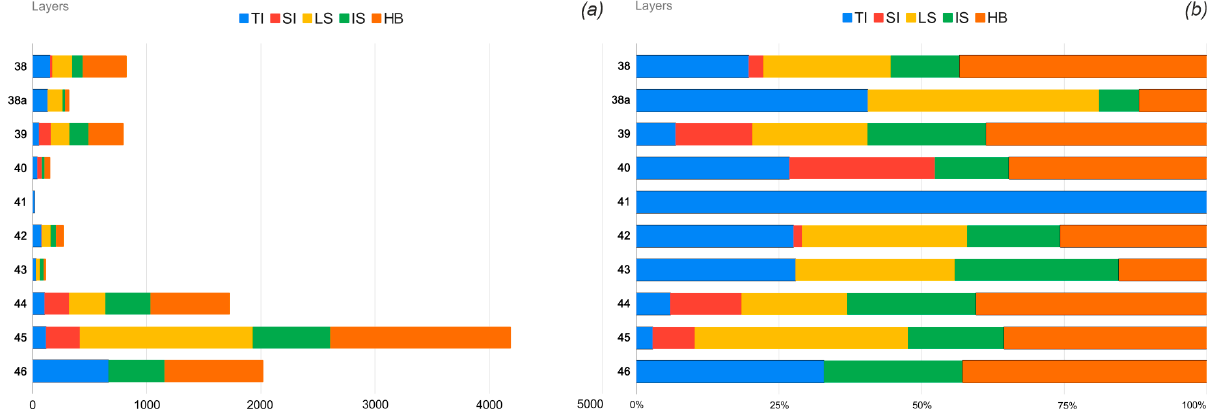
Figure 6. Ladder diagrams showing contributions to structural complexity (bits per unit cell) ( a ) and normalized contributions (in %) ( b ) for the structures based on uranyl carbonate layers. Legend: see Figure 5. See Table 2 and text for details.